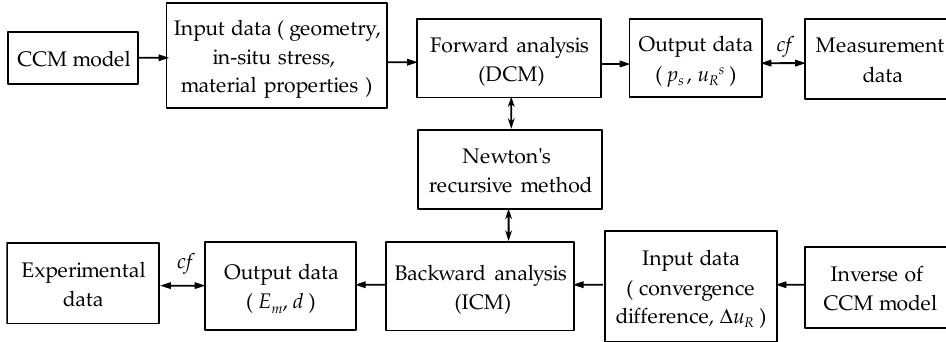
Figure 2. Explicit algorithm process of DCM and ICM in the analysis of CCM in tunneling.